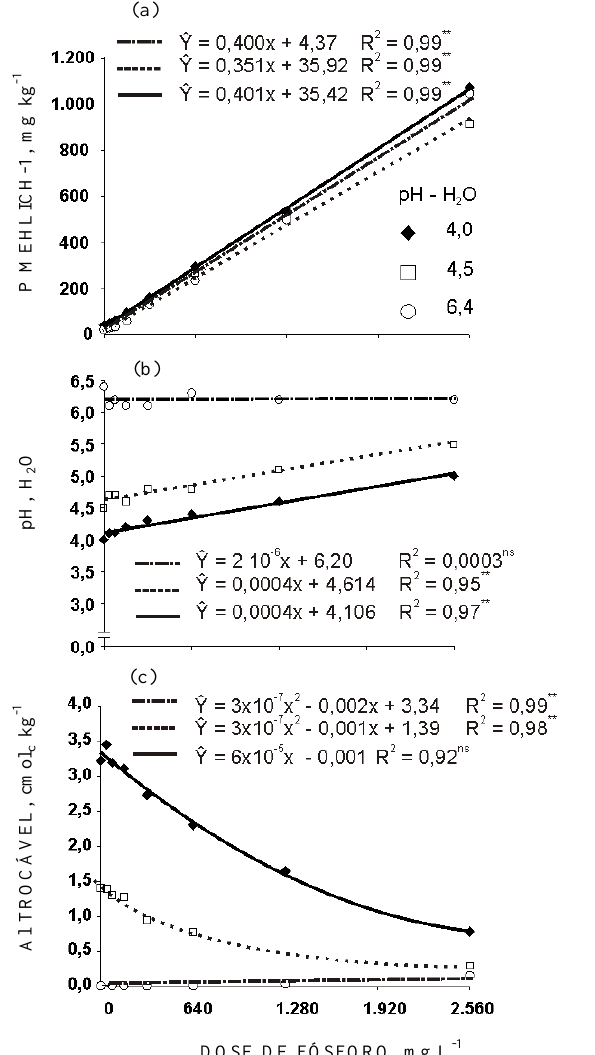
Figura 1. Atributos químicos em colunas de solo afetados pela aplicação de doses de fósforo em diferentes condições de pH sob plantio direto: fósforo disponível (a); pH em H trocável